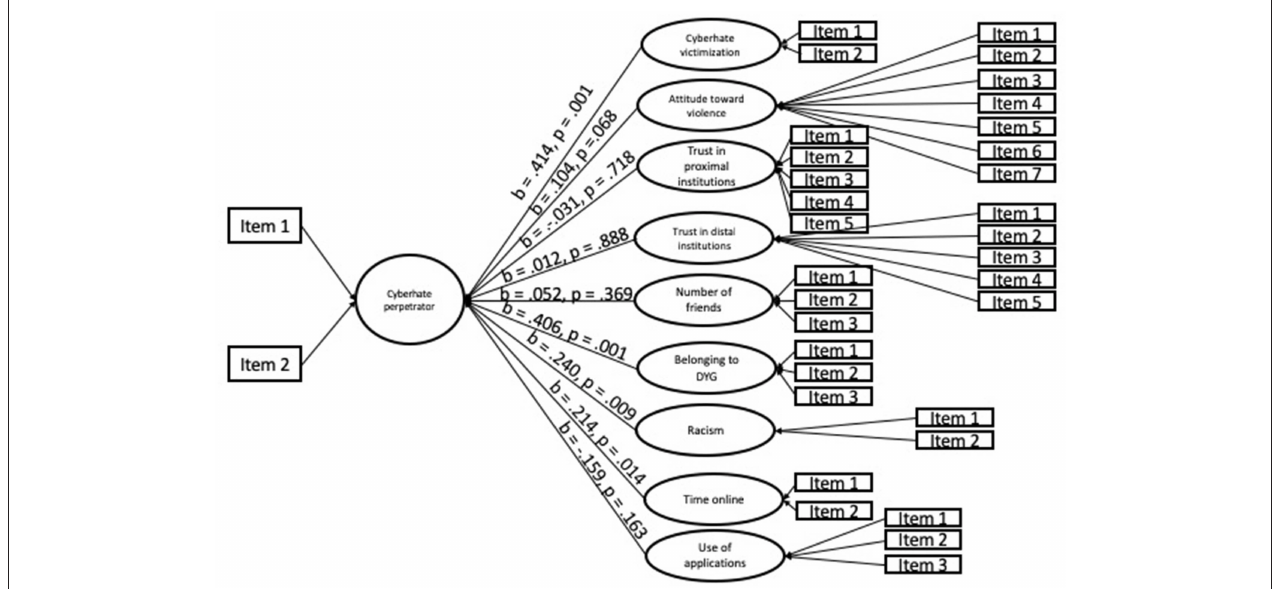
FIGURE 1 | Standardized regression estimates between latent factors.